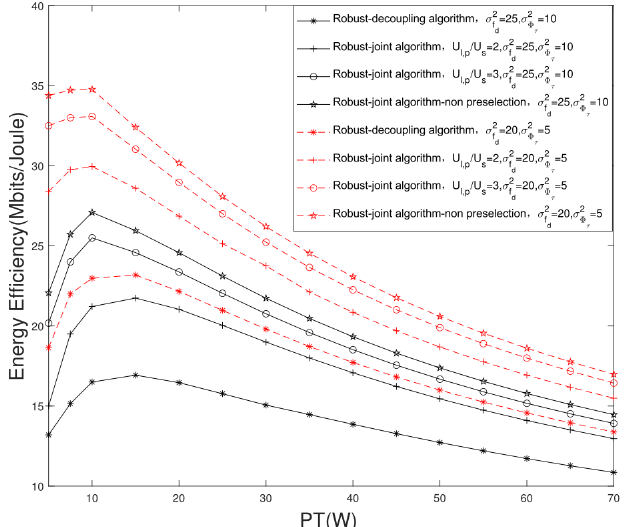
Figure 8. Comparison of system EE of different algorithms with different transmission power thresholds P T